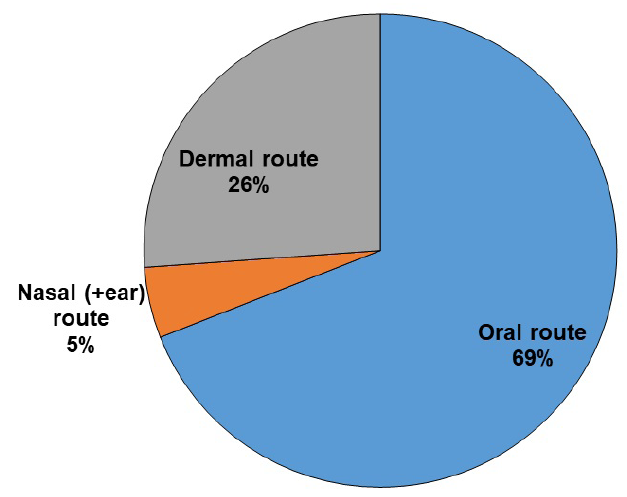
Figure 8. Administration routes used for ethnomedicinal plants used against snakebite in Ethiopia.